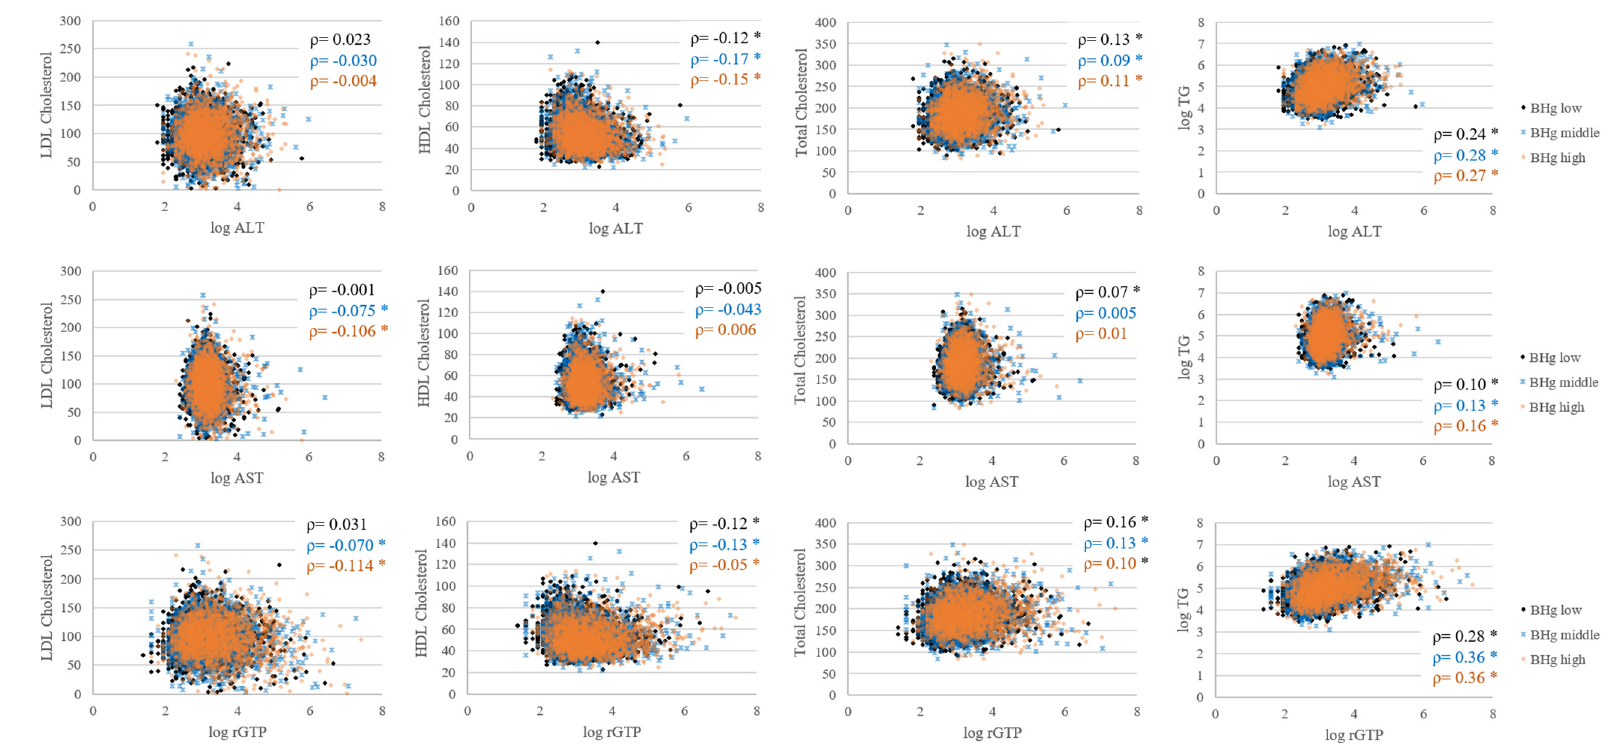
Figure 2. Correlations between the lipid profiles and hepatic enzymes in each blood Hg group. The x-axes represent the natural log scale of hepatic enzymes, and the y-axes represent the lipid profiles including natural log scale of TG. The black, blue, and orange colors indicate low, middle, and high blood Hg levels, respectively. ‘ ρ ’ represents the correlation coefficient, and * indicates the significance of the correlation coefficient ( p < 0.05). BHg on the left side of the figure indicates blood Hg.